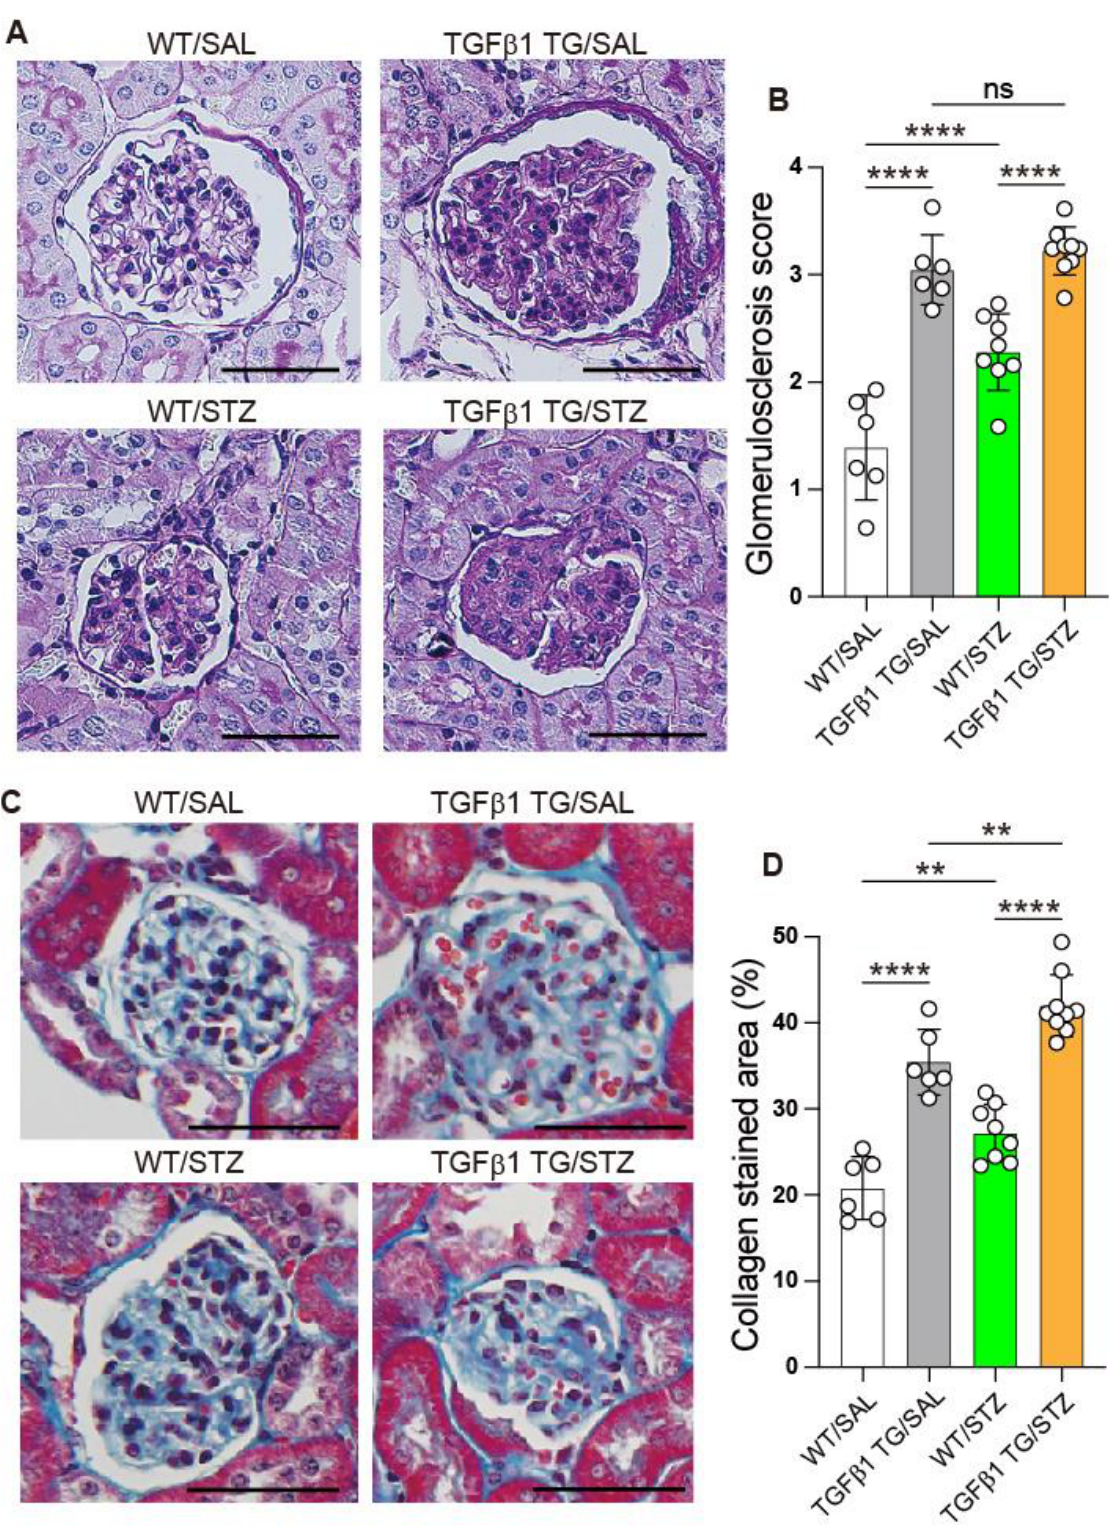
Figure 7. Progressive glomerulosclerosis in transforming growth factor β 1 transgenic mice with diabetes mellitus. Renal tissues were cut and stained with periodic acid–Schiff ( A , B ) or Masson’s trichrome ( C , D ) and then quantified using a scoring system or the WinROOF imaging software. Scale bars indicate 50 µm. Number of mice: WT/SAL n = 6, TGFβ1 TG/SAL n = 6, WT/STZ n = 8, TGFβ1 TG/STZ n = 9. Statistical analysis by ANOVA with Newman–Keuls’ test. ** p < 0.01; **** p < 0.0001. WT, wild- type mice, TGFβ1 TG, transforming growth factorβ1 transgenic mice.